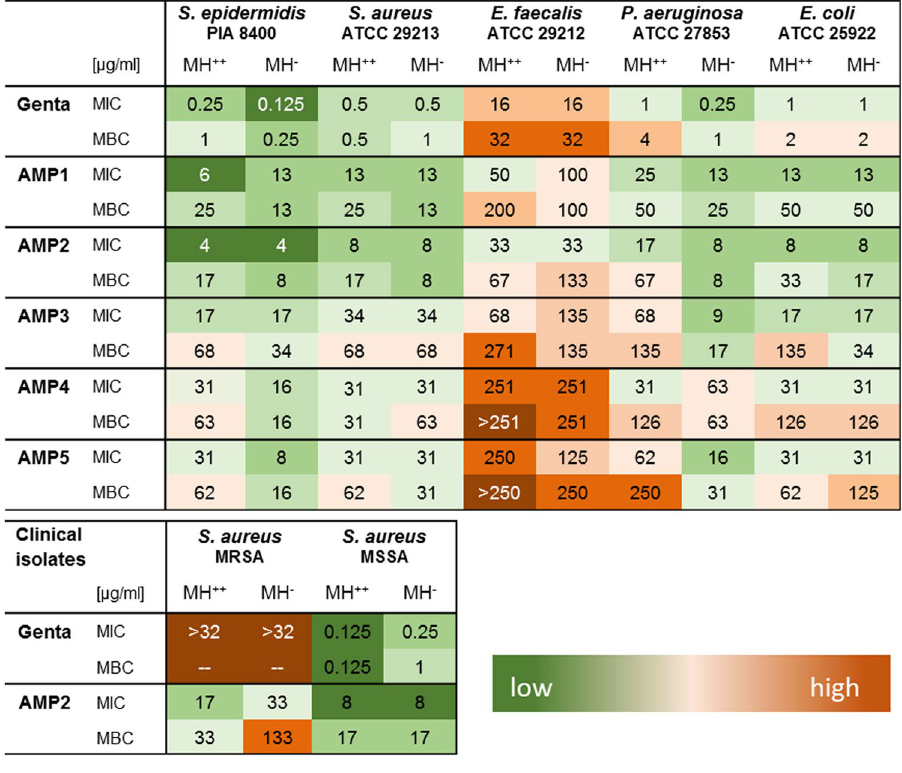
Figure 1. Minimal inhibitory concentration (MIC) and minimal bactericidal concentration (MBC) in µ g/ml for gentamicin (Genta) and for five different AMPs. MH ++ : Mueller-Hinton bouillon with cations (n = 4–8), MH − : Mueller-Hinton bouillon without cations (n = 4). Color code: green low concentration, dark orange high concentration needed for antimicrobial